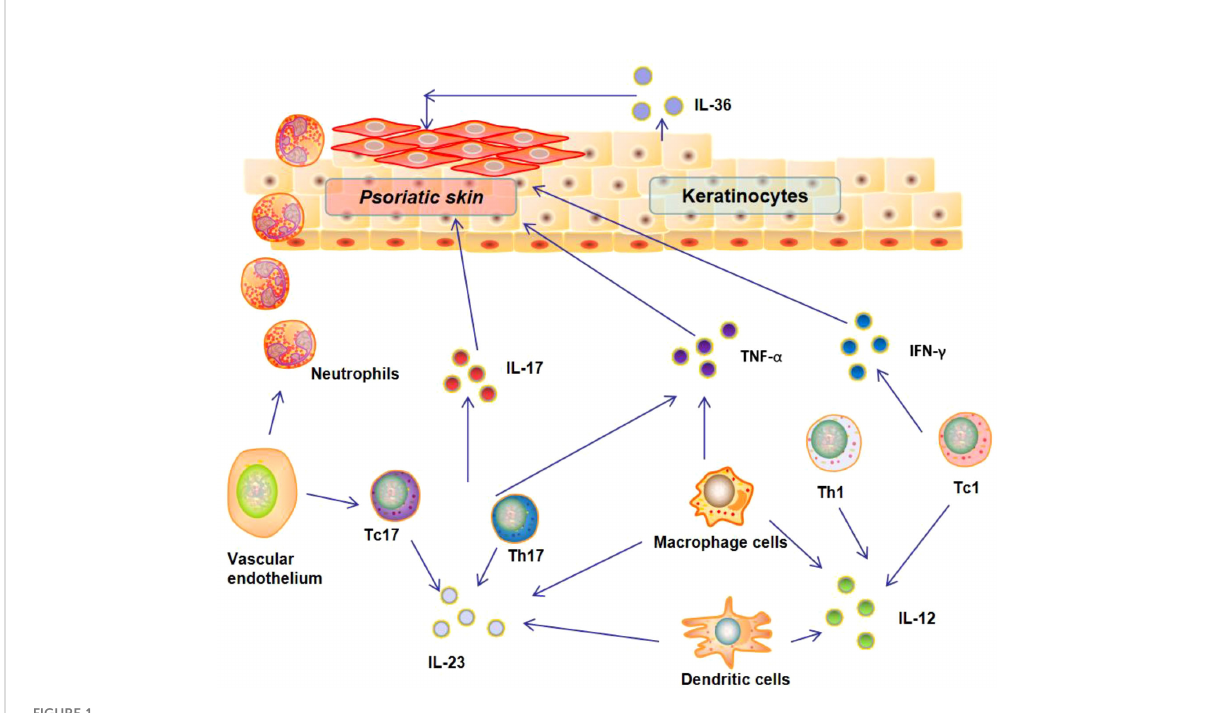
FIGURE 1 In fl ammatory factor loop and immune dysfunction in